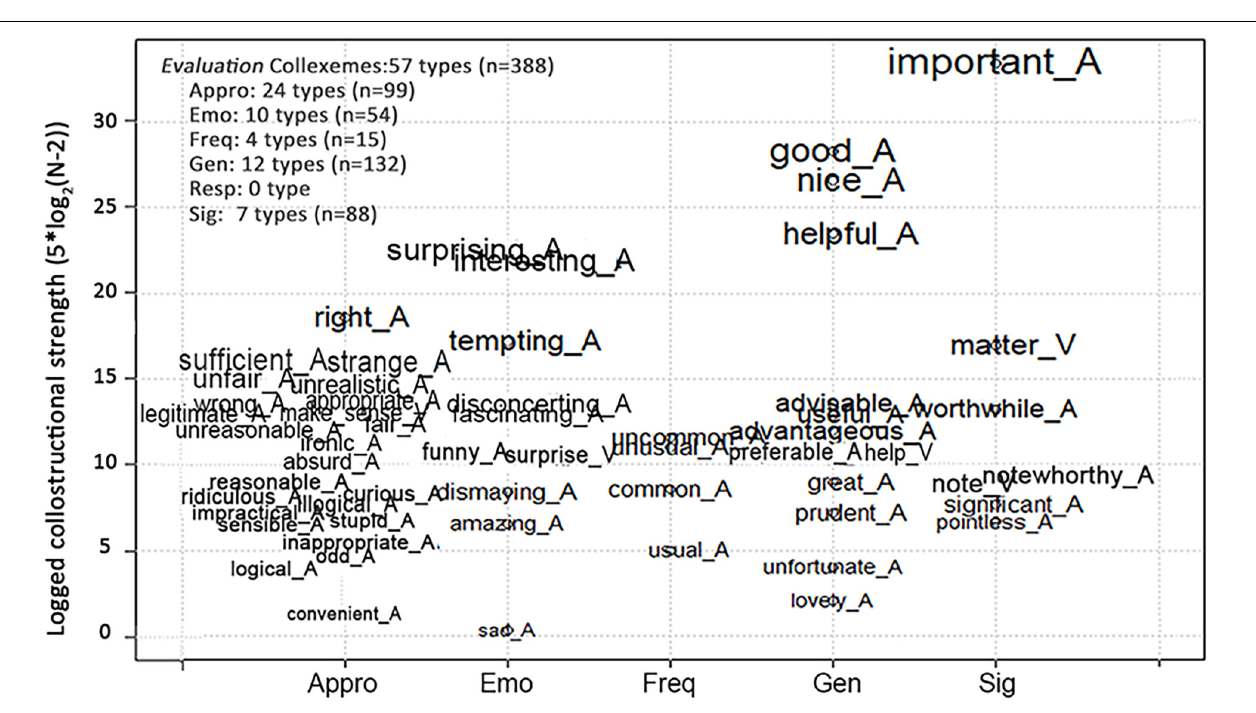
FIGURE 2 | Logged CLSs of the Evaluation